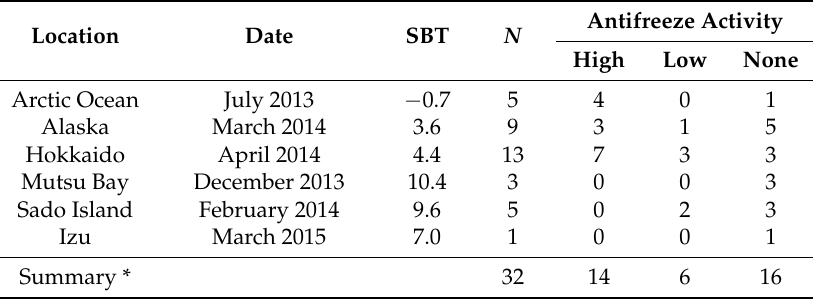
* Include duplicated